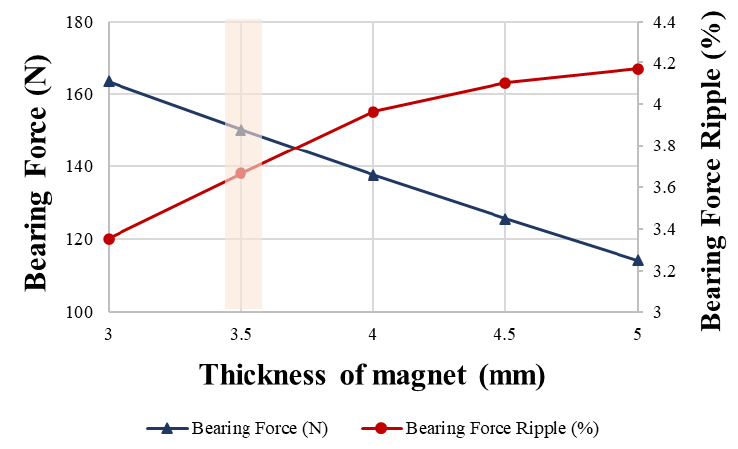
Figure 16. Torque and ripple according to the thickness of the magnet.